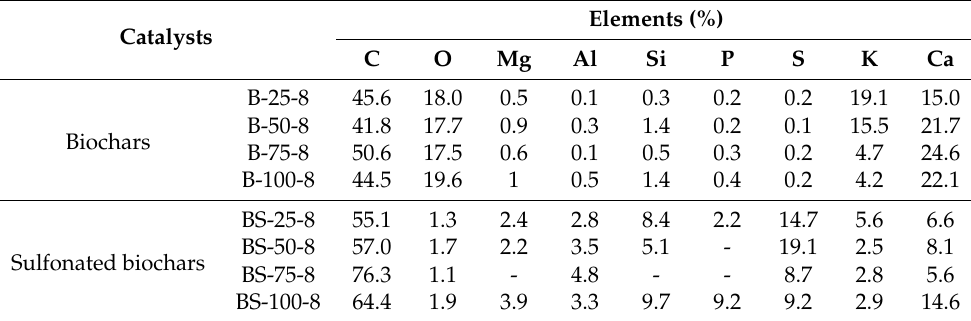
Table 2. Elemental composition of the biochars obtained at 800 ◦ C.